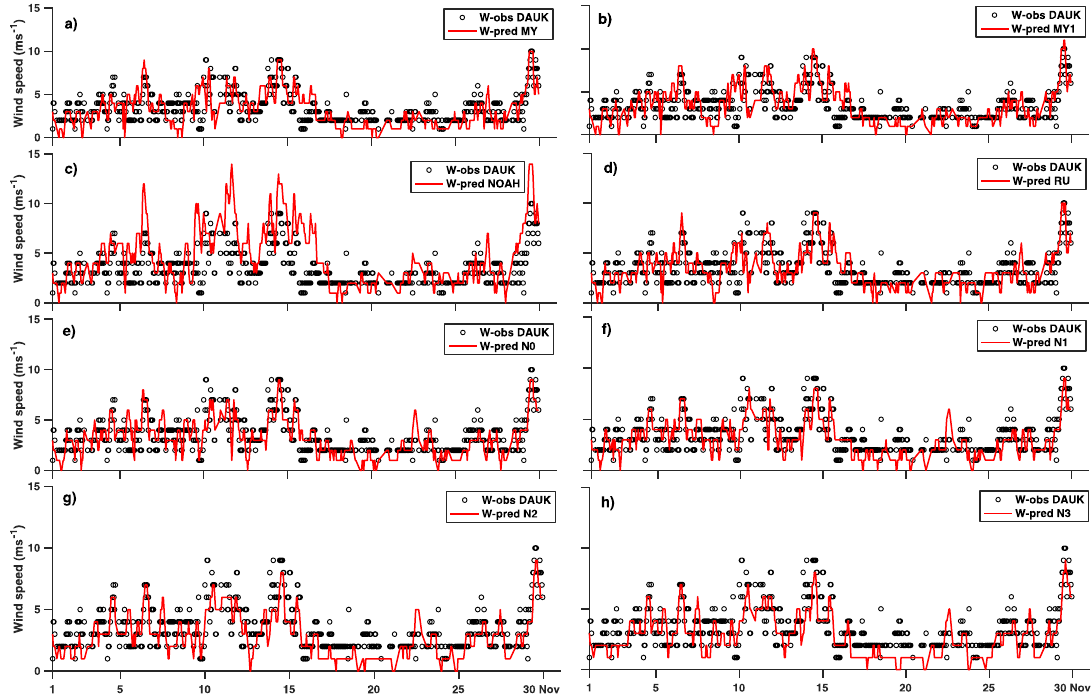
Figure 5. Time series of wind speed observed at DAUK meteorological station versus wind speed predicted by MY ( a ), MY1 ( b ), NOAH ( c ), RU ( d ), N0 ( e ), N1 ( f ), N2 ( g ), N3 ( h ) simulations.